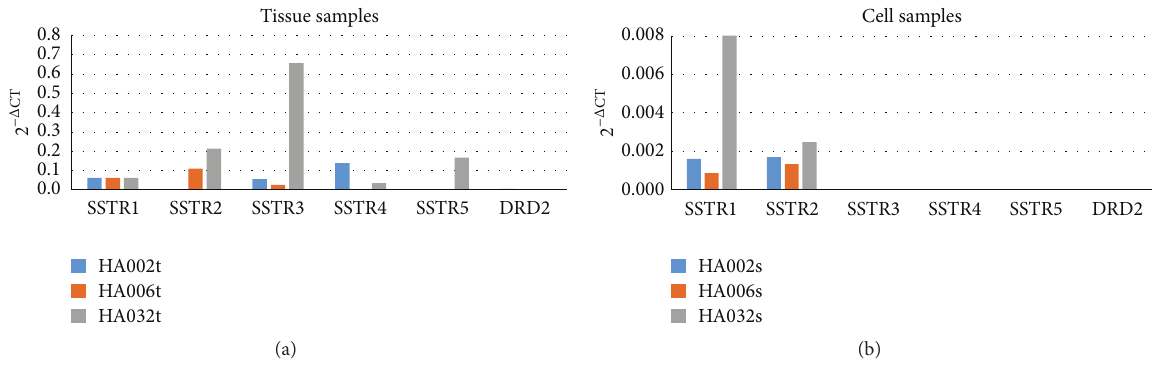
Figure 8: Somatostatin and dopamine receptor expression in tissue samples (a) and corresponding cell cultures (b). Values are calculated using comparative ( 2 −Δ Ct ) method and mean Ct values from experiments performed in triplicate. Although adenoma tissue samples showed meaningful expression of somatostatin and dopamine receptors (a), their expression in cell cultures was not substantial (b). SSTR1–5, somatostatin receptors 1 to 5; DRD2, dopamine receptor